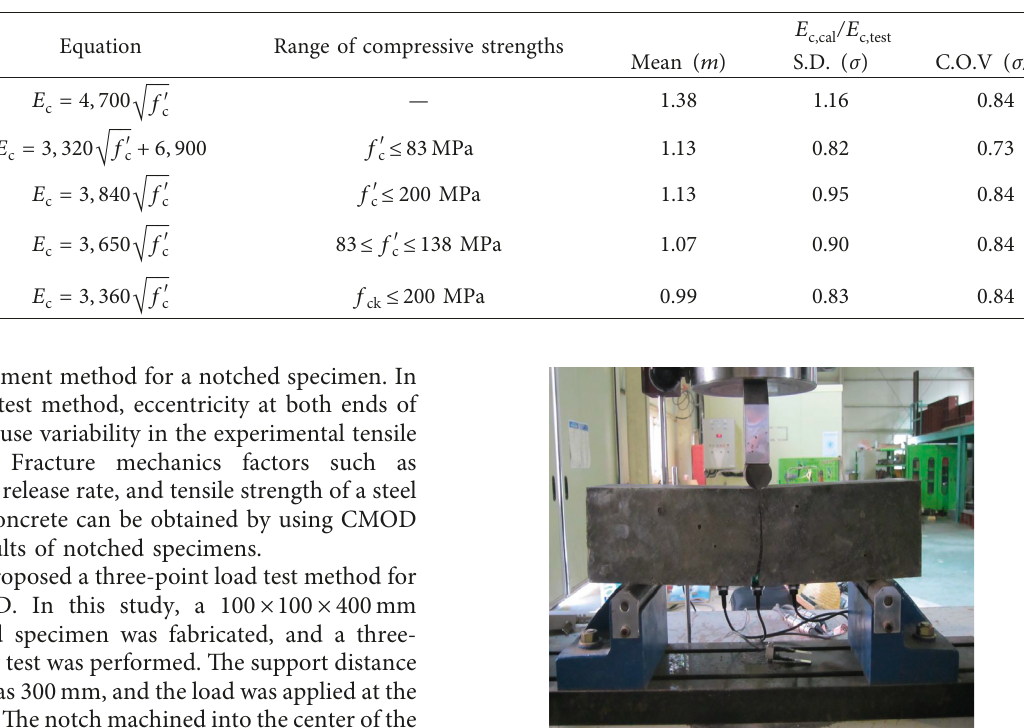
Figure 3: Prediction of the elastic modulus at various compressive Table 5: Comparison of the test results and prediction of the elastic modulus.